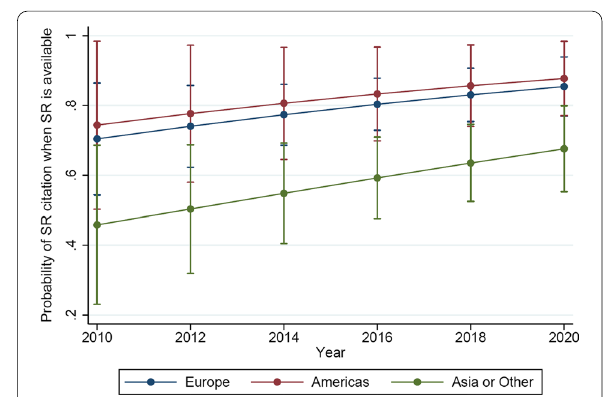
Fig. 3 Probability of SR inclusion per continent of corresponding author and year of